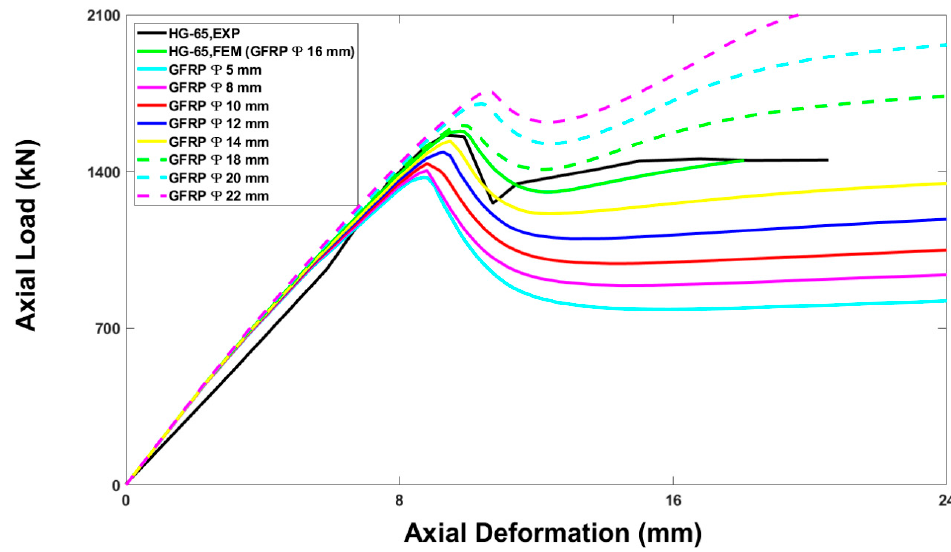
Figure 21. Effect of longitudinal reinforcement